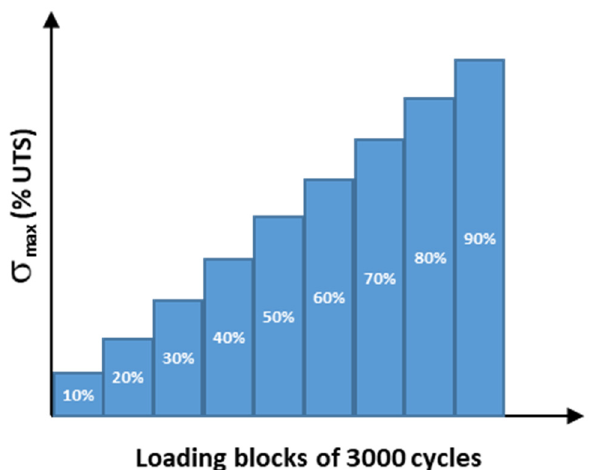
Figure 10. Applied fatigue loading profile during hybrid non-destructive testing